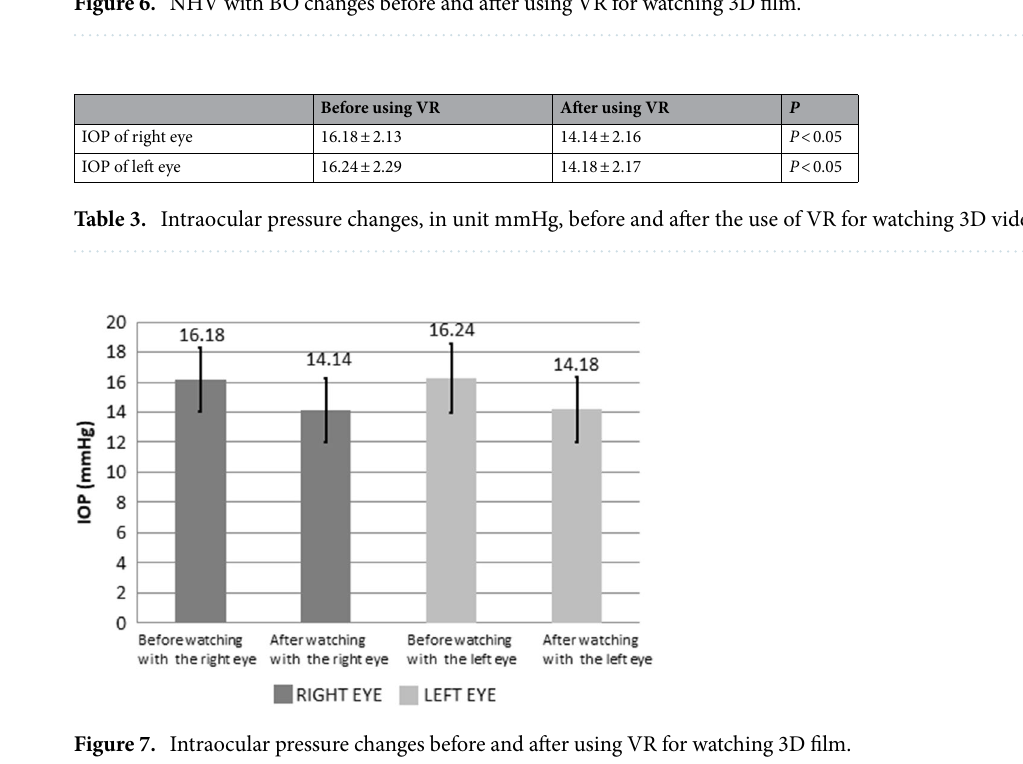
Figure 6. NHV with BO changes before and after using VR for watching 3D film.